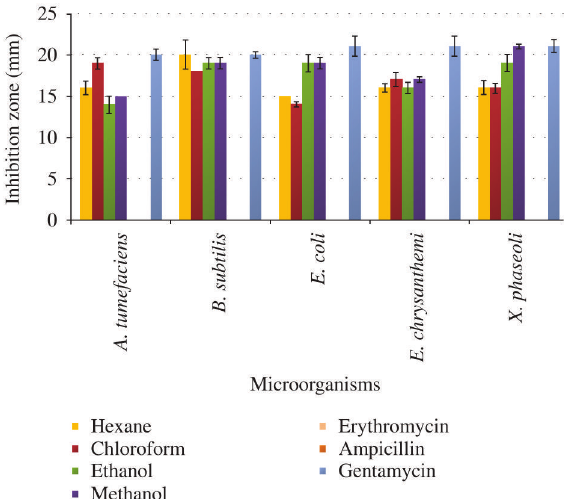
FIGURE 2: Inhibition zones (in mm) observed in methanol, ethanol, chloroform, and hexane extracts as compared to ampicillin, erythromycin, and gentamycin. Bar represents standard errors and mean value of inhibition zone.